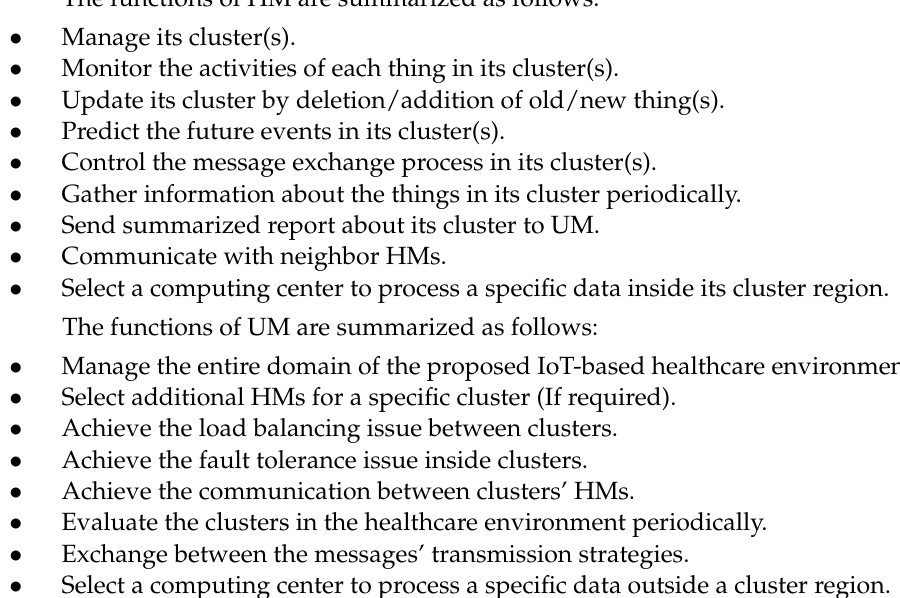
Table 1. Management messages and their summarized functions.